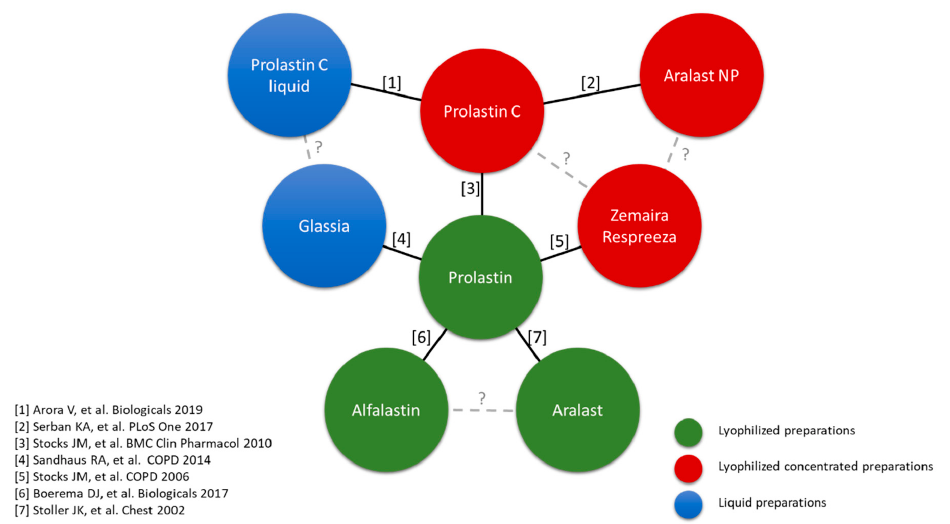
Figure 4. Temporal distribution of the years of approval of augmentative AAT treatments in the USA (upper) and Europe and European countries, with their own presentation (lower). In red: year of initial official approval. In blue: year when company changed. LFB, Laboratoire français du fractionnement et des biotechnologies.